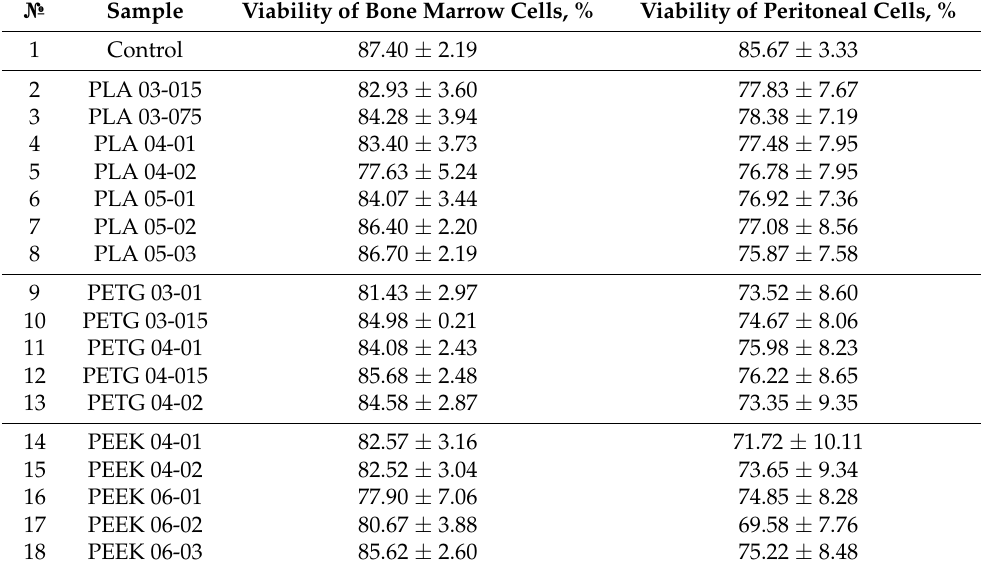
Table 2. Relative viability of the bone marrow cells and the peritoneal lavage cells after 12 h